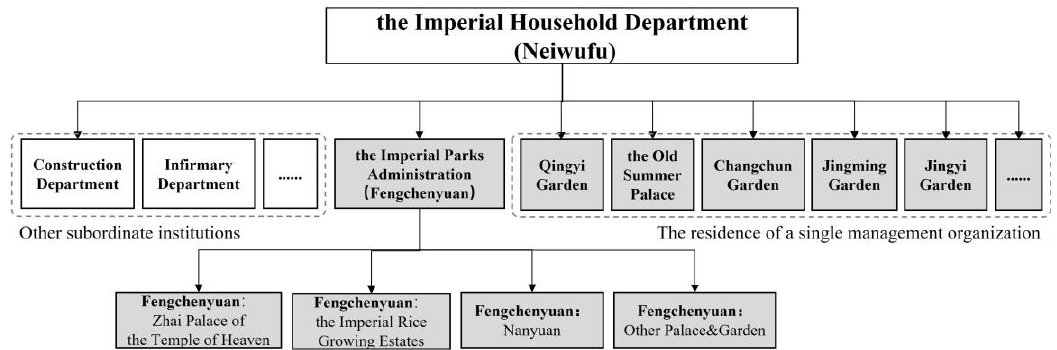
Figure 14. Spatial distribution and density analysis map of other land.